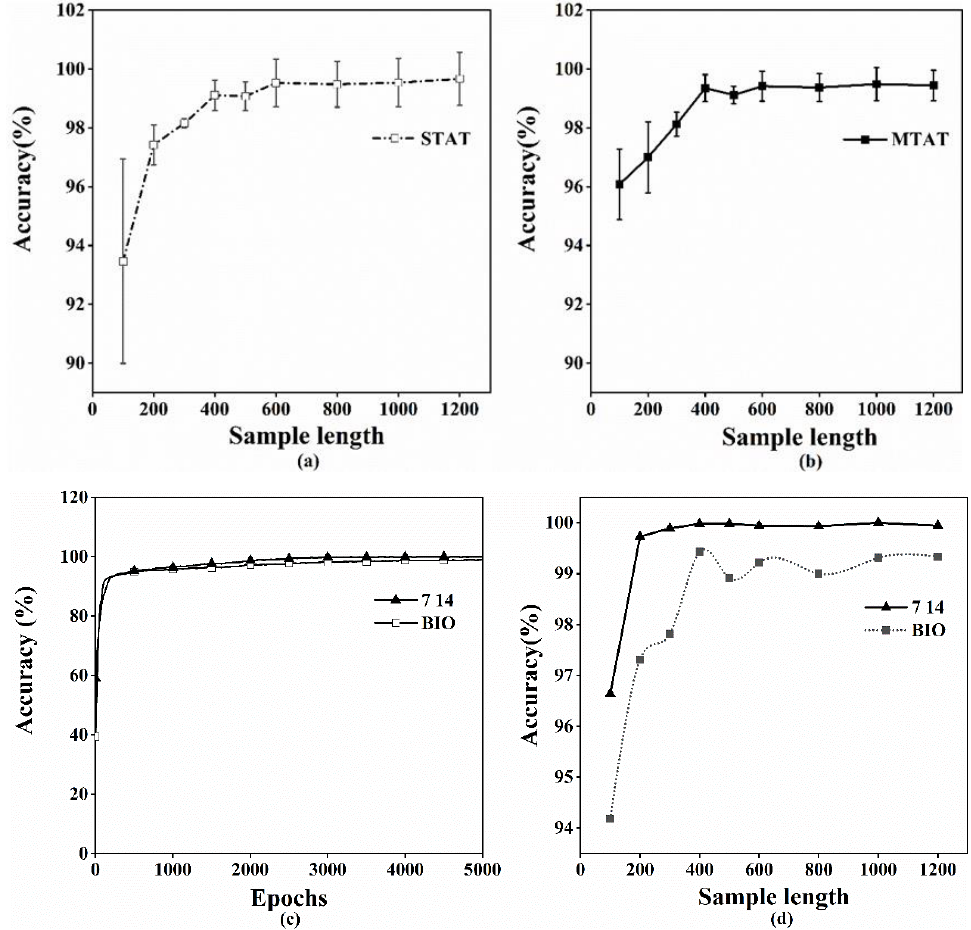
Figure 13. ( a ) Accuracy of the STAT; ( b ) accuracy of the MTAT; ( c ) Accuracy of subtasks under optimal sample length; ( d ) Accuracy of subtasks with different sample lengths.